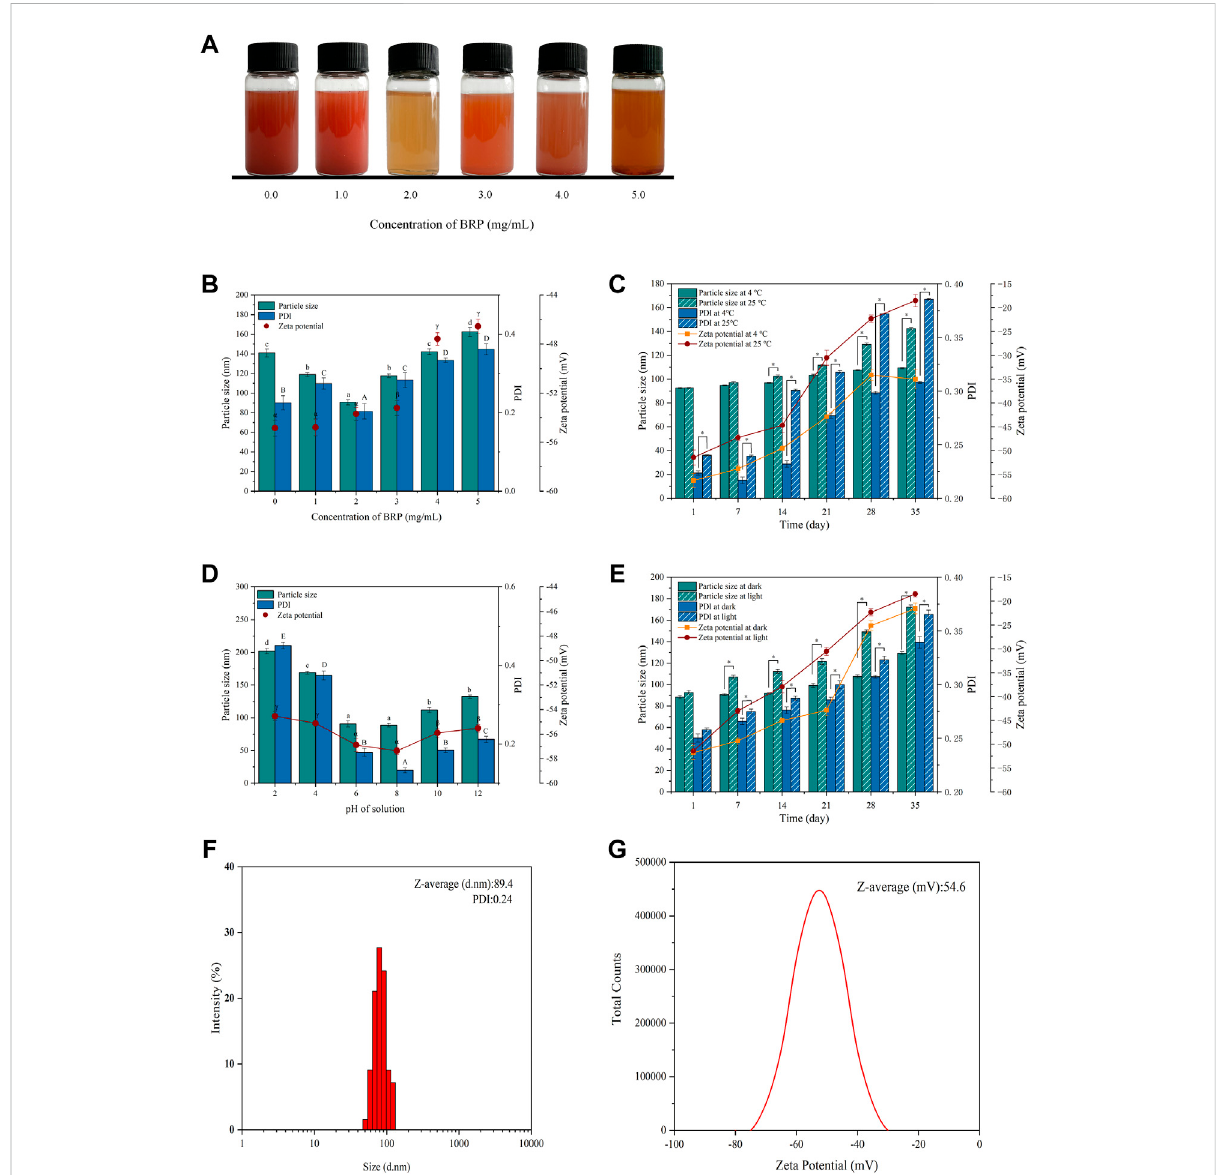
FIGURE 1 (A) Selenium nanoparticles synthesized with different concentrations BRP. (B) The in fl uence of BRP concentration on the particle size, PDI and zeta potential of SeNPs. The in fl uence of (C) temperature, (D) pH and (E) light conditions on the stability of SeNPs during 35 days of storage. (F) The particle size, PDI and (G) Zeta potential of BRP-SeNPs. The different letters indicate signi fi cant differences ( p < 0.05). Comparisons between experimental groups were conducted by using one-way ANOVA, * p <